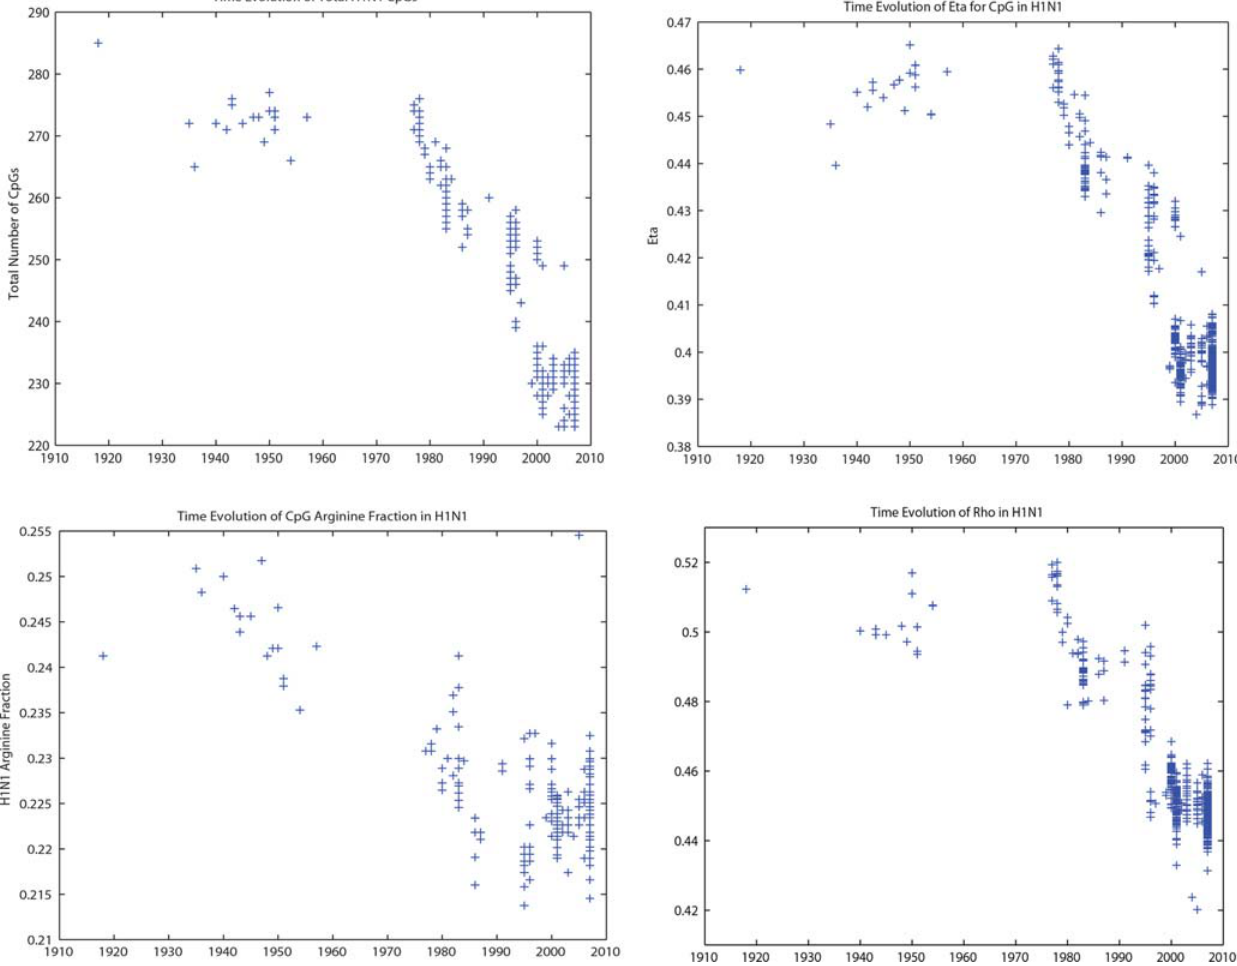
Figure 4. Different measures of dinucleotide suppression applied to the evolution of the human H1N1 virus. Upper left figure: Evolution of the number of CpGs in human H1N1 influenza A virus from 1918–2007. Upper right figure: Evolution of the odds ratio g = CpG/C.G in human H1N1 influenza A virus from 1918–2007. Lower left figure: Evolution of the ratio (r) of CG Arginine (CGN) codons over the total number of arginines (CGN, AGA, AGG) in human H1N1 influenza A virus from 1918–2007. Lower right figure: Evolution of the r index in human H1N1 influenza A virus from 1918–2007.